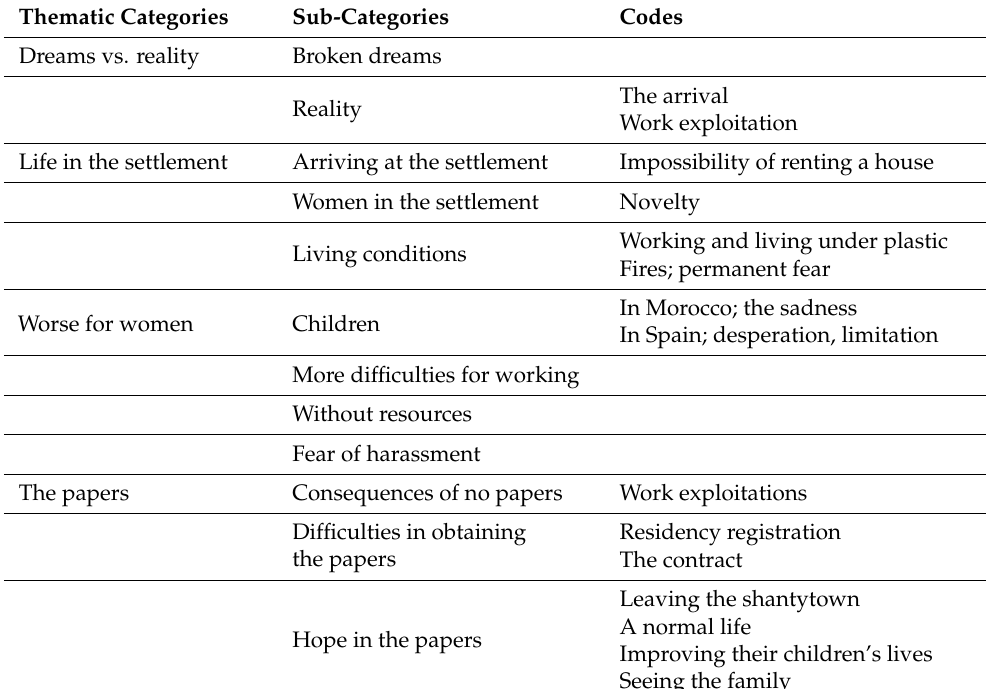
Table 2. Thematic categories. Thematic